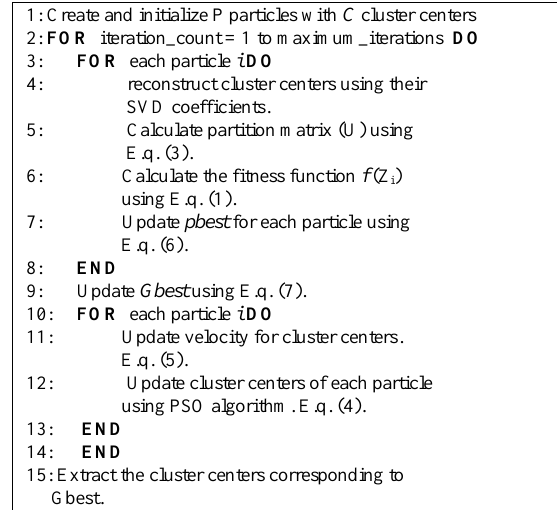
Table 2. Proposed method pseudo-code.